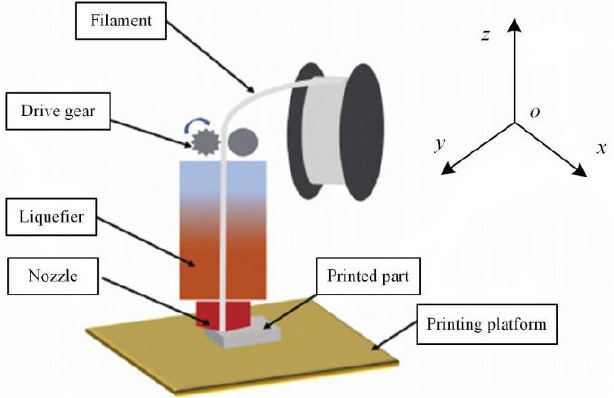
Figure 1. Schematic diagram of FDM.